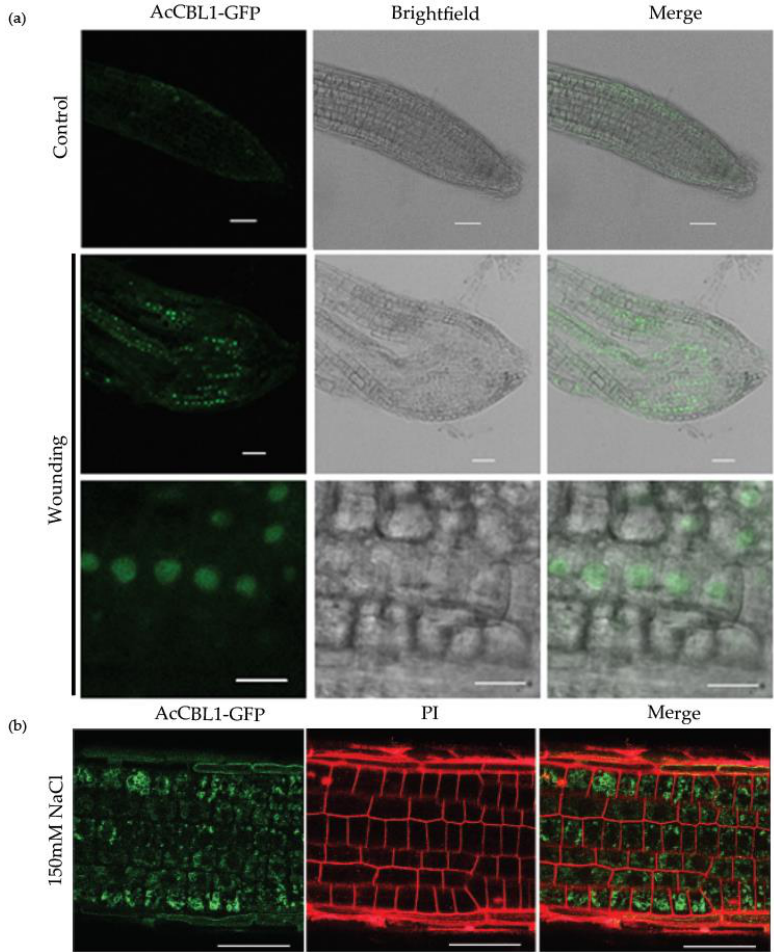
Figure 8. Ac CBL1-GFP translocalizes to nucleus from cytosol after injury. ( a ) Localization Ac CBL1-GFP in the nucleus when the 7-day-old root of transgenic seedlings is injured. ( b ) Ac CBL1-GFP localization in cytosol after salt stress. GFP fluorescence is represented in green and PI fluorescence channel is represented in red. Scale bars = 50 μm.